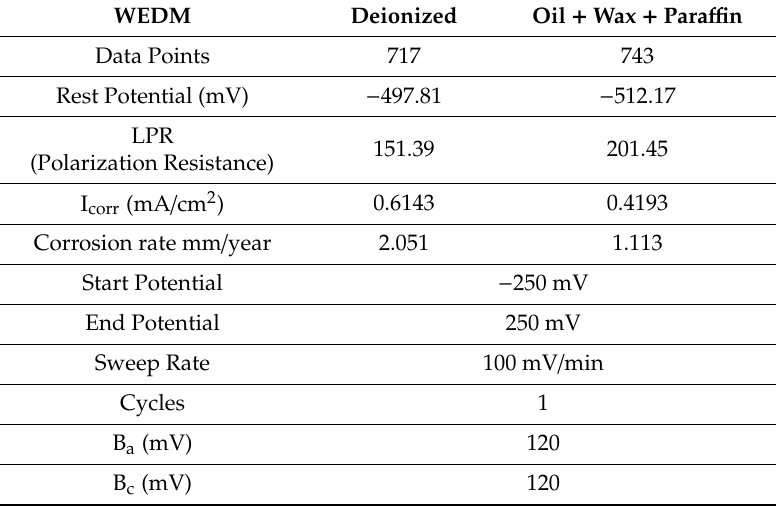
Figure 15. Corrosion data analysis for wire electrical discharge machining of the Al-SiC-TiC metal matrix composite under deionized and oil + wax + paraffin dielectric mediums. Table 15. Corrosion data recording for the wire electrical discharge machined Al-SiC-TiC metal matrix composite under deionized and oil–wax–paraffin (OWP) dielectric mediums. WEDM